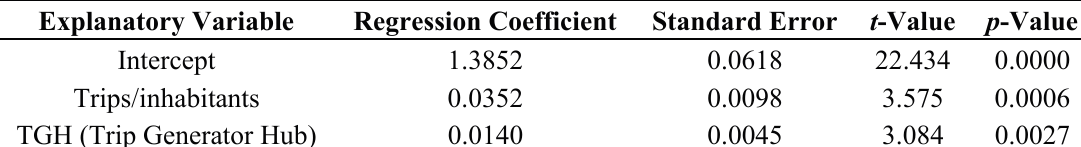
Table 1. OLS regression model: São Paulo, total VRU traffic